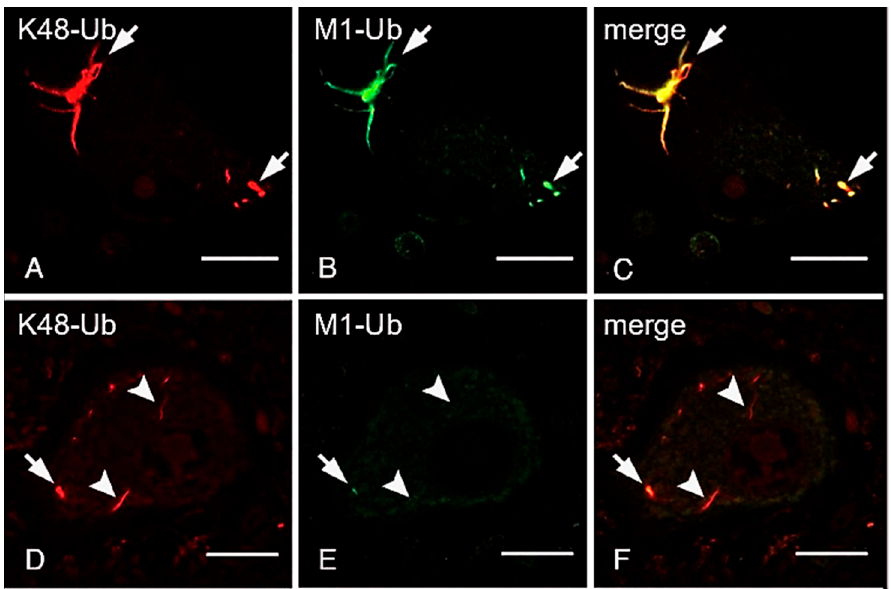
Figure 4. Thick bundles of inclusions are immunopositive for anti-K48 and anti-linear ubiquitin antibodies, whereas fine wisps exclusively reacted with anti-K48 ubiquitin, but not anti-linear ubiquitin. The double immunofluorescence staining using anti-K48-linked ubiquitin antibody ( A , D ), anti-linear ubiquitin antibody ( B , E ), and their merged images ( C , F ) are shown. Arrows; neuronal cytoplasmic inclusions co-localized with K48- and linear-ubiquitins. Arrowheads; K48-ubiquitin-positive inclusions, which lack immunoreactivity for anti-linear ubiquitin antibody (Bars = 20 µ m, modified from Ref. [144] with permission ).